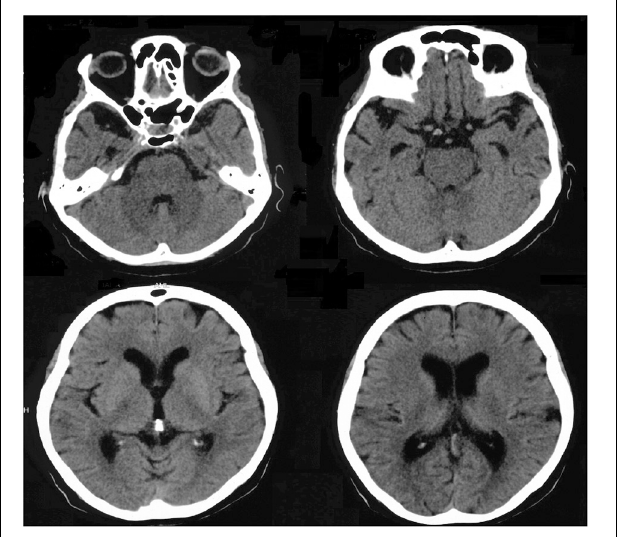
FIGURE 1 | Brain computed tomography scan performed in 2009 showing marked atrophy in bilateral temporopolar and frontal regions.